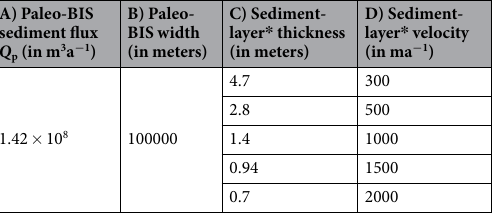
that a significant volume of sediment transported in basal ice layers could be deposited at the grounding line 36 . Hence, the paleo sediment flux across the grounding line depends on the combined contribution of deformation till and sediment concentrated in basal ice layers. We assume that the relatively high erosion rate of 0.625 mma − 1 used here reflects an upper bound input of all sedimentary material to the CGZW, whether transported to the paleo-grounding line subglacially or in the basal ice. The width of the paleo Bindschadler Ice Stream on the outer shelf is ~100,000 m (Fig. 1). A paleo sediment flux of 1.42 × 10 8 m 3 a − 1 could have been associated with